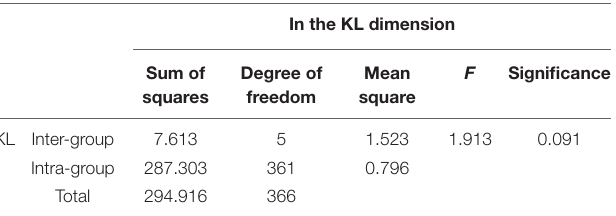
TABLE 5 | The differences of new entrepreneurs.